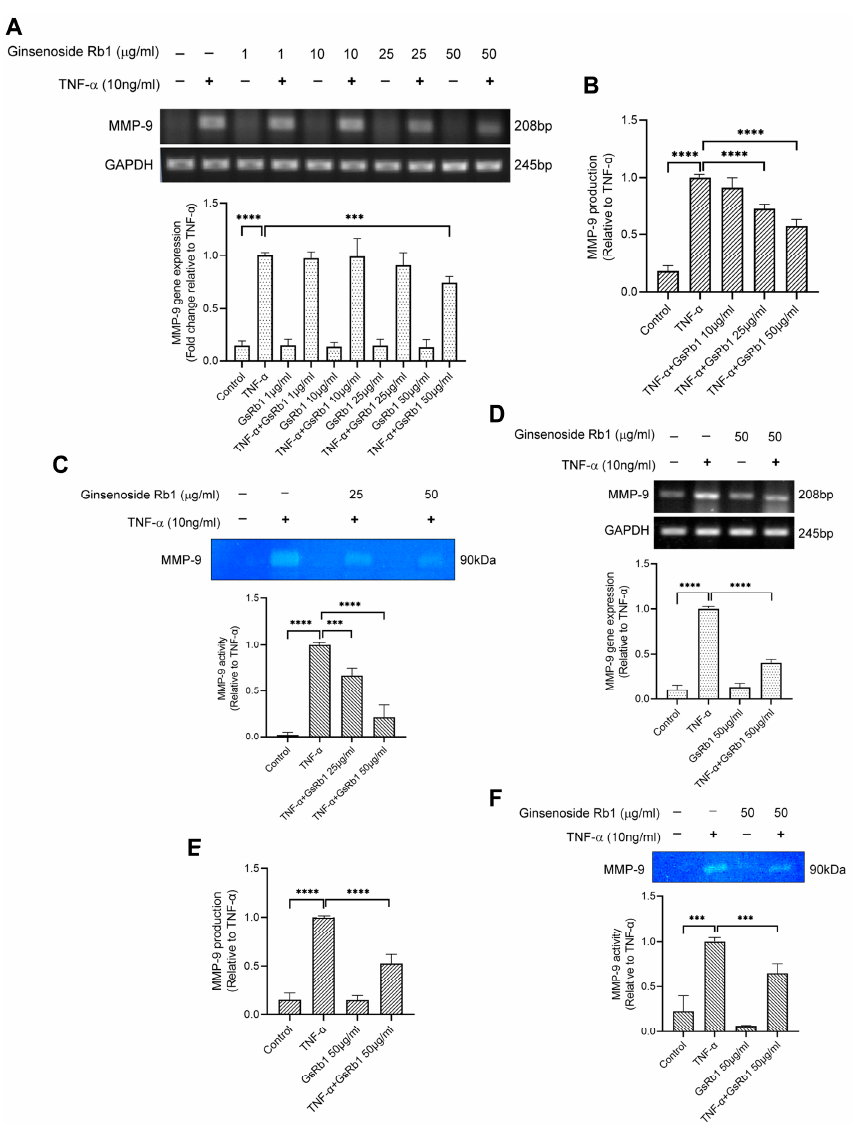
Figure 4. Effects of Ginsenoside Rb1 (GsRb1) on MMP-9 production in H9c2 and HepG-2 cells. ( A ) Effect of GsRb1 on TNF- α -induced MMP-9 gene expression in H9c2 cells. Cells (5 × 10 4 )